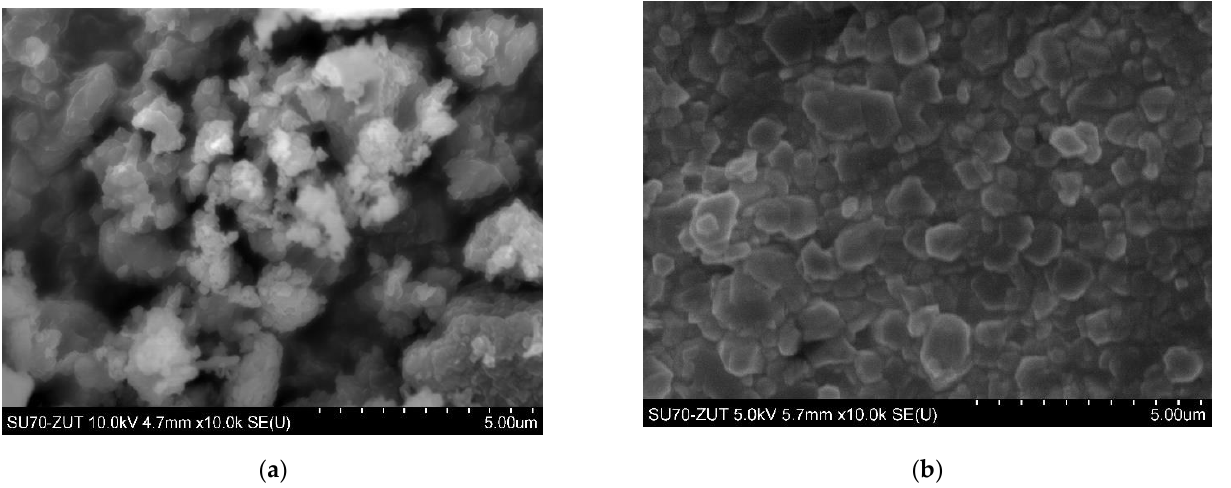
Figure 1. Scanning electron micrographs of nanofillers used in the study: ( a ) HNTs (as received); ( b ) ATH-sil (as received). Table 1. Compositions of the prepared